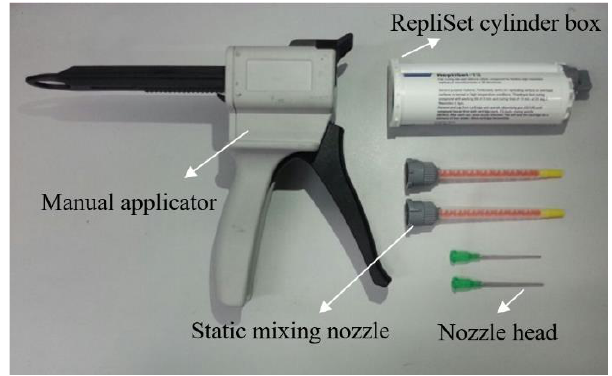
Figure 4. Replication system for surface replication.